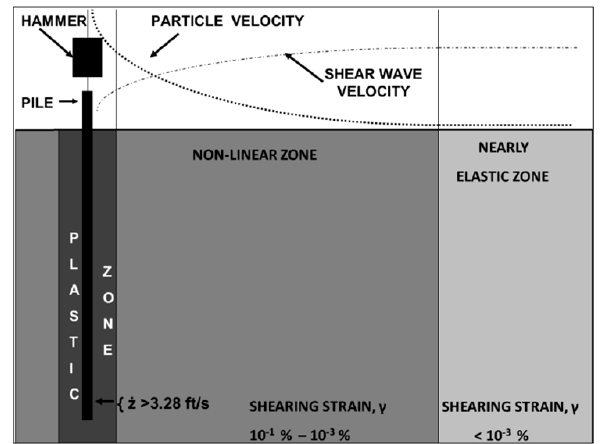
Figure 14. Hypothetical soil behavior zones near a driven pile.